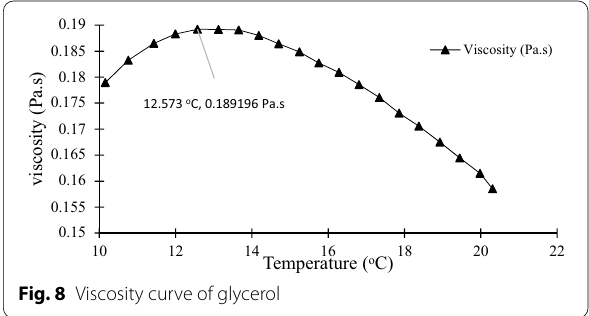
Fig. 8 Viscosity curve of glycerol